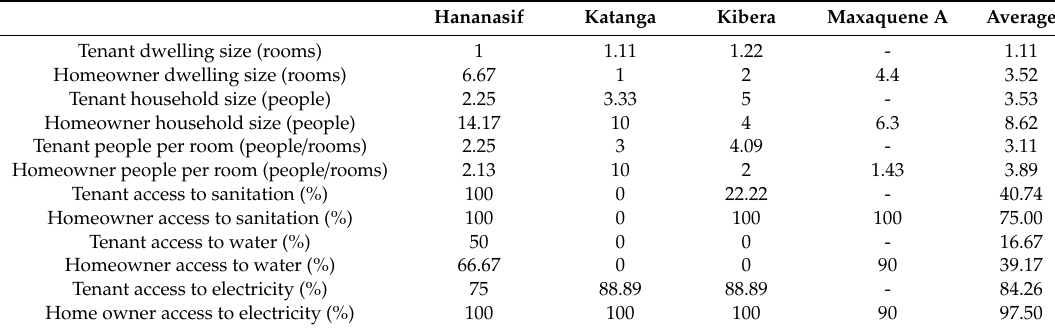
Table 2. Tenant / homeowner di ff erentiated interview data.